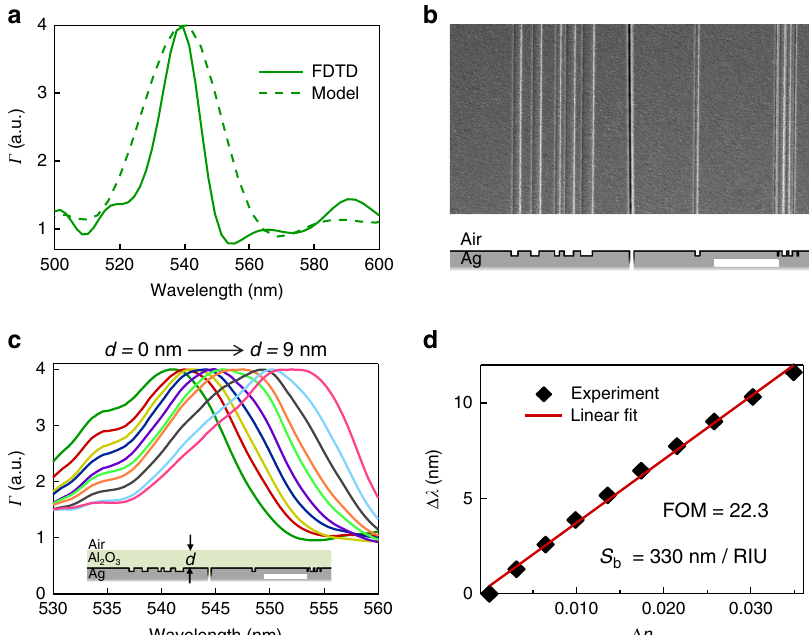
Fig. 5 Linewidth optimization and refractive index sensing. a Spectral response, calculated using the interference model of Eq. (3) (dashed lines) and full- fi eld FDTD simulations (solid lines), of a linewidth optimized aperiodic slit-groove device using Ag as the substrate upon illumination with a TM polarized light at θ = 0°. The relative transmission ( Γ ) exhibits a peak at 540 nm with a linewidth of 14.1 nm corresponding to a resonance quality factor of ≈ 38. b Top-down SEM image of the optimized device fabricated using the procedure outlined in Supplementary Fig. 6 along with the model predicted surface cross-section pro fi le of the optimized device at a Ag-air interface. Scale bar represents 2 μ m. c Experimentally measured spectral response as a function of increasing Al 2 O 3 layer thickness, varying from 0 to 9 nm, for the device in b . Inset shows the surface cross-section pro fi le of the optimized device with top Al 2 O 3 layer. Scale bar represents 2 µ m. d Peak spectral shift ( Δ λ ) vs. refractive index change ( Δ n ) for the data in c , resulting in a bulk sensitivity S b = 330 nm/RIU and a fi gure-of-merit (FOM) ≈ 22.3. The FOM value achieved here is comparable to that of the state-of-the-art surface plasmon resonance sensors